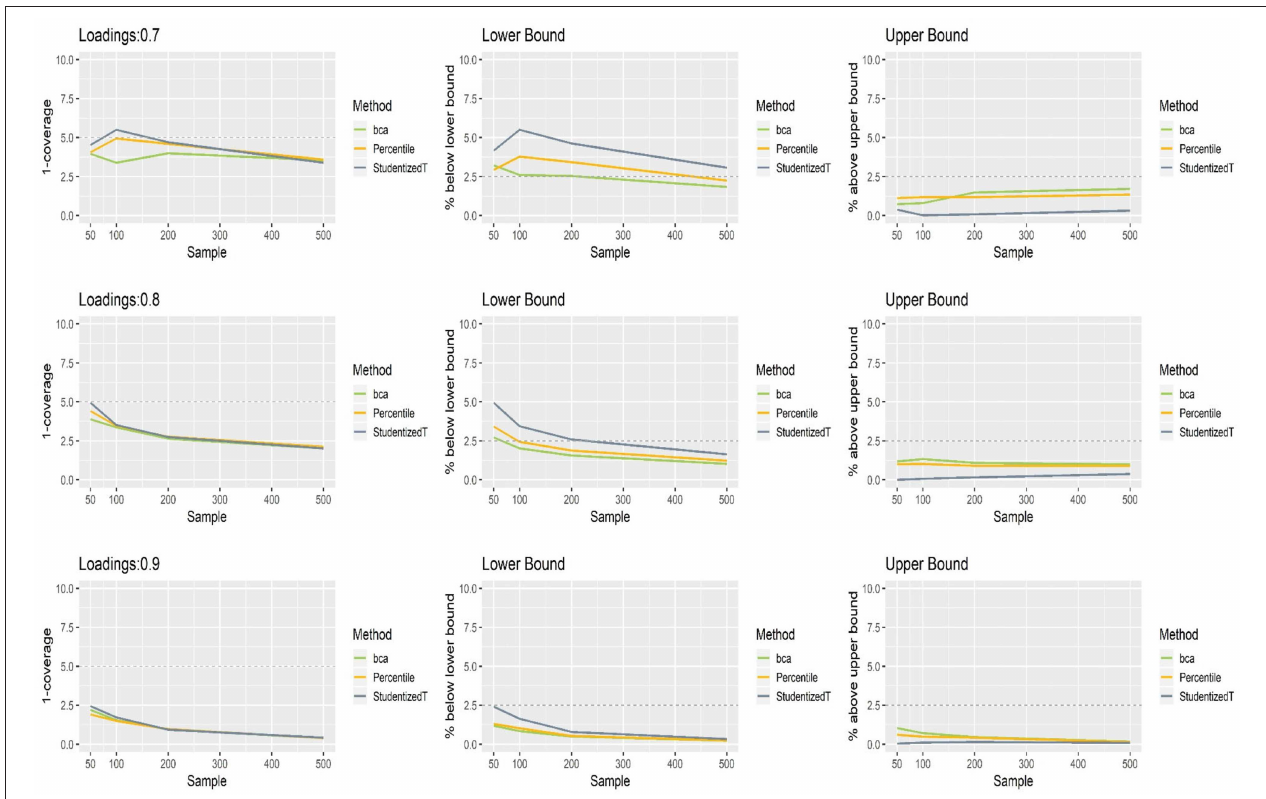
FIGURE 2 | The coverage and balance of percentile, bias-corrected and accelerated bootstrap (BCa), and Student’s t 95% confidence intervals (CIs) of 0.7, 0.8, and 0.9 loadings for normal indicators.